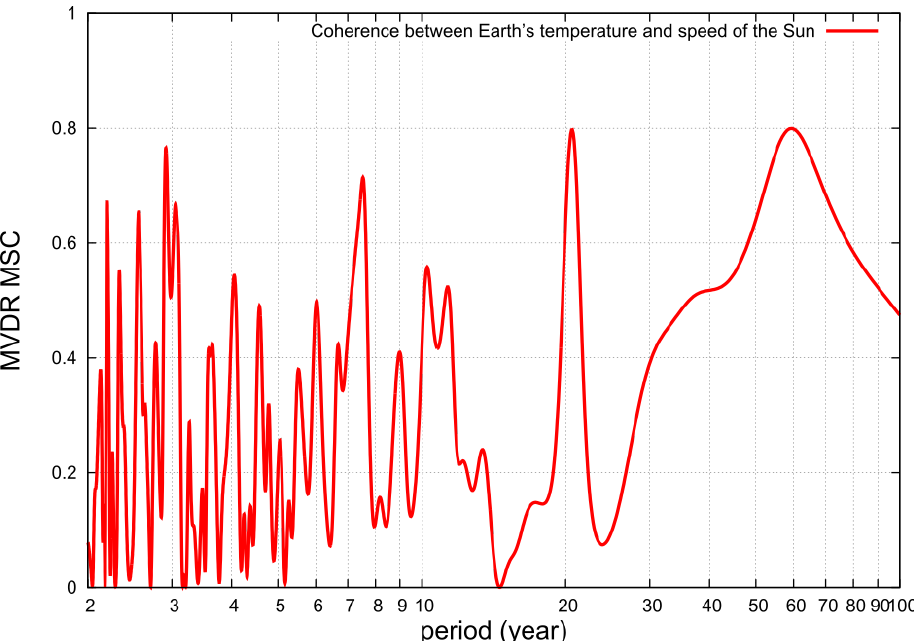
Figure 12. The magnitude squared coherence (MSC, with windows length L = 102 years, Equation (10)) between the temperature component filtered of the anthropogenic and volcano signal (Figure 8A) and the speed of the sun relative to the barycenter of the solar system [42]. The Capon’s approach known as the minimum variance distortion-less response (MVDR) method [136]. Major coherence harmonics are found at about 3, 7.5, 20 and 60 years. An extended coherence at 10–12 years, which corresponds to the solar cycle, is also